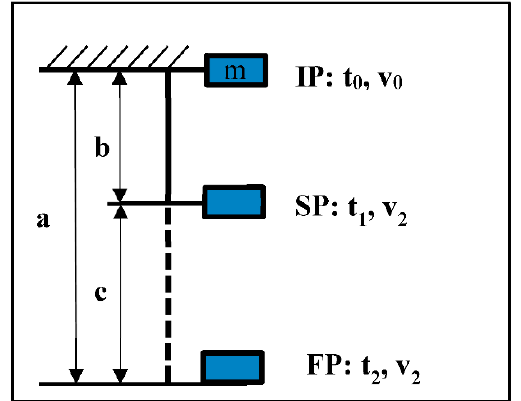
Figure 13. Free falling condition of the head-cutting subset: ( a ) distance from the home position of the head-cutting subset to the end of the cutting path, ( b ) the length from the home position to the initial contact of the blade and trout (80 mm), and ( c ) head-cutting width. In this figure, IP, SP, and FP are the initial, start, and final positions.